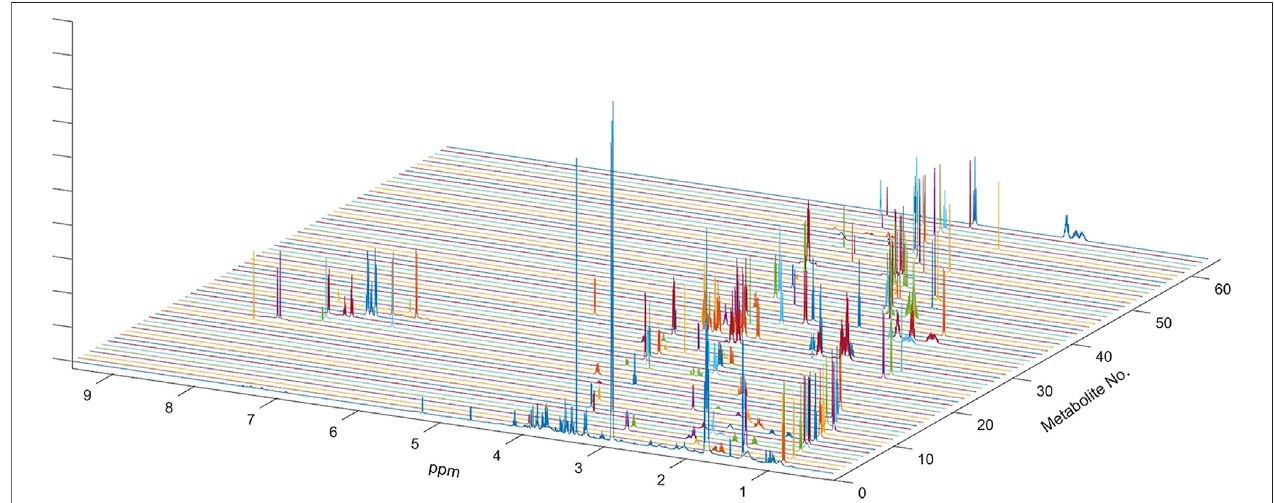
FIGURE 1 | NMR spectrum of metabolites used for multi-linear regression analysis of the global spectrum. Sixty-three metabolites used in the analysis included all metabolitespreviouslydeterminedintheHMDBandalsocon fi rmedontheChenomxNMRSuite.One-dimensionalspectraofallsixty-threemetabolitesareshownalong with the outline of the average spectrum for the serum sample. Complete spectra of all metabolites were used in multivariate linear regression analysis.